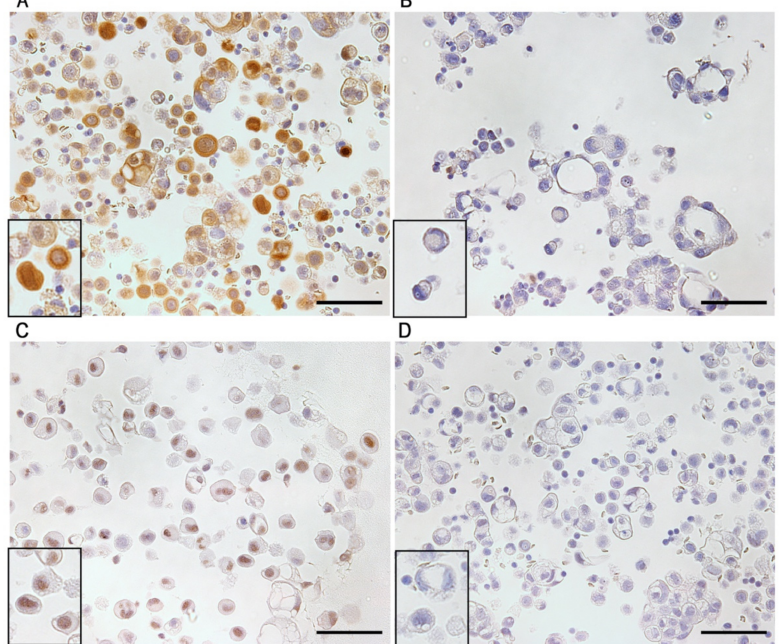
Figure 1. Immunohistochemistry of aldehyde dehydrogenase 1 (ALDH1) and Sal-like 4 (SALL4) expression in the malignant pleural effusion of lung adenocarcinoma. ALDH1-positive ( A ), ALDH1- negative ( B ), SALL4-positive ( C ), and SALL4-negative ( D ) cells. The insets present a higher- magnification image in each panel. The bars indicate 50 µ m.